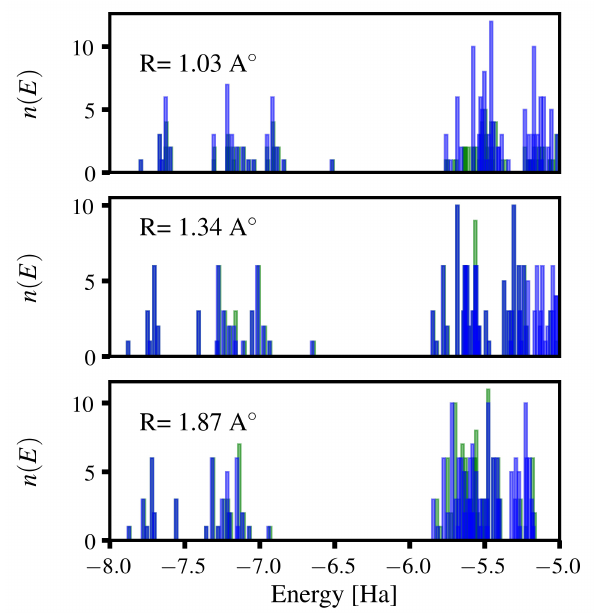
Figure 5. The unnormalizaed density of states for LiH at different binding distances. The blue fill indicates the exact, and the green fill indicates